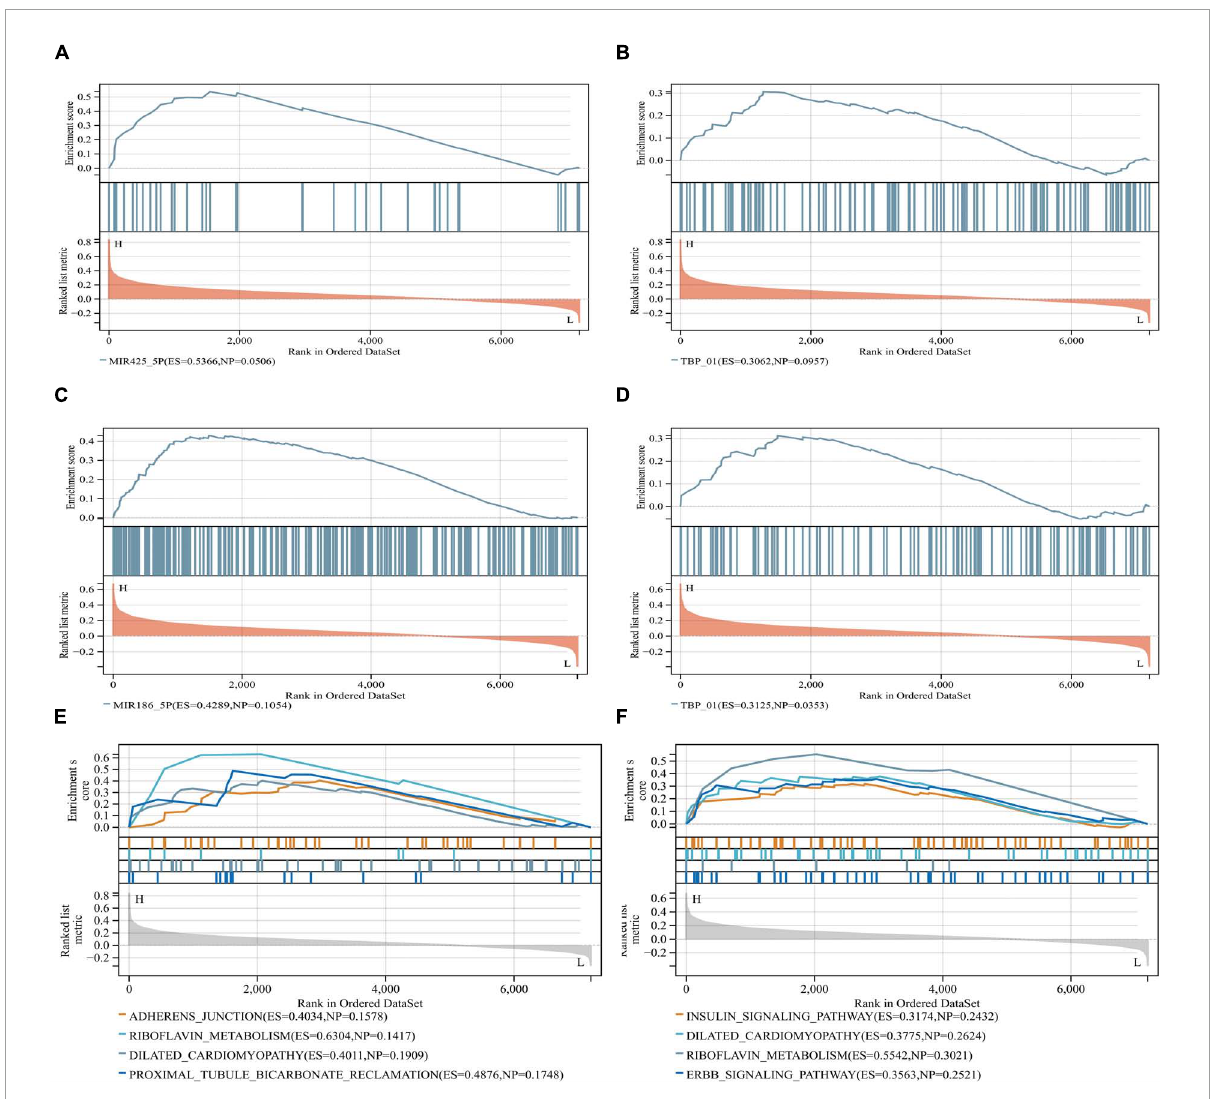
FIGURE11 GSEA software was used to assess miRNA and TBP in similar biological pathways with target genes. (A,B) Grouped according to gene expression profiles and phenotypes, and evaluated related pathways and molecular mechanisms to validate the regulate of the hsa-miR-425-5p and TBP to the target gene GRIA1. (C,D) Validated regulate of hsa-miR-186 and TBP to the target gene GRM5, and indicate that they are on the relevant biological pathway. (E,F) They are GRIA1 and GRM5, respectively, and their corresponding miRNA-related biological